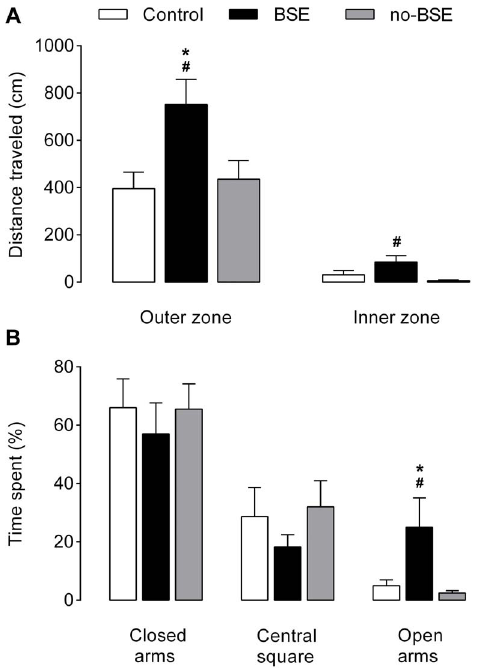
Figure 1. Behavior of kainate-treated rats in the open-field (A) and elevated plus-maze (B) tests. The y-axis represents the distances travelled by rats during the 5-min testing sessions in the outer and inner zones of the open-field apparatus, and in the central zone and open and closed arms of the plus-maze apparatus. Note that rats who had experienced behavioral status epilepticus (BSE group) traveled longer distances in the outer and inner zones of the open field when compared to control rats and rats that had not experienced behavioral status epilepticus (no-BSE group), respectively. In the plus- maze test, rats in the BSE group spent more time in the open arms of the apparatus than rats in the other two groups. * p , 0.05 vs. control group and # p , 0.05 vs. no-BSE group. Data are presented as the mean 6 SEM.